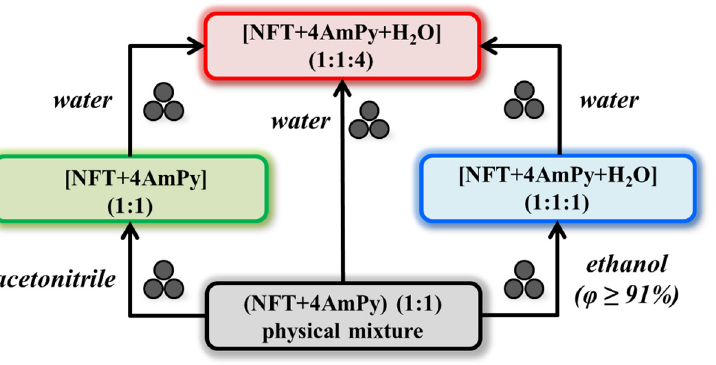
Scheme 1. Schematic representation of preparation and transformation of the NFT multicomponent solid forms via LAG.